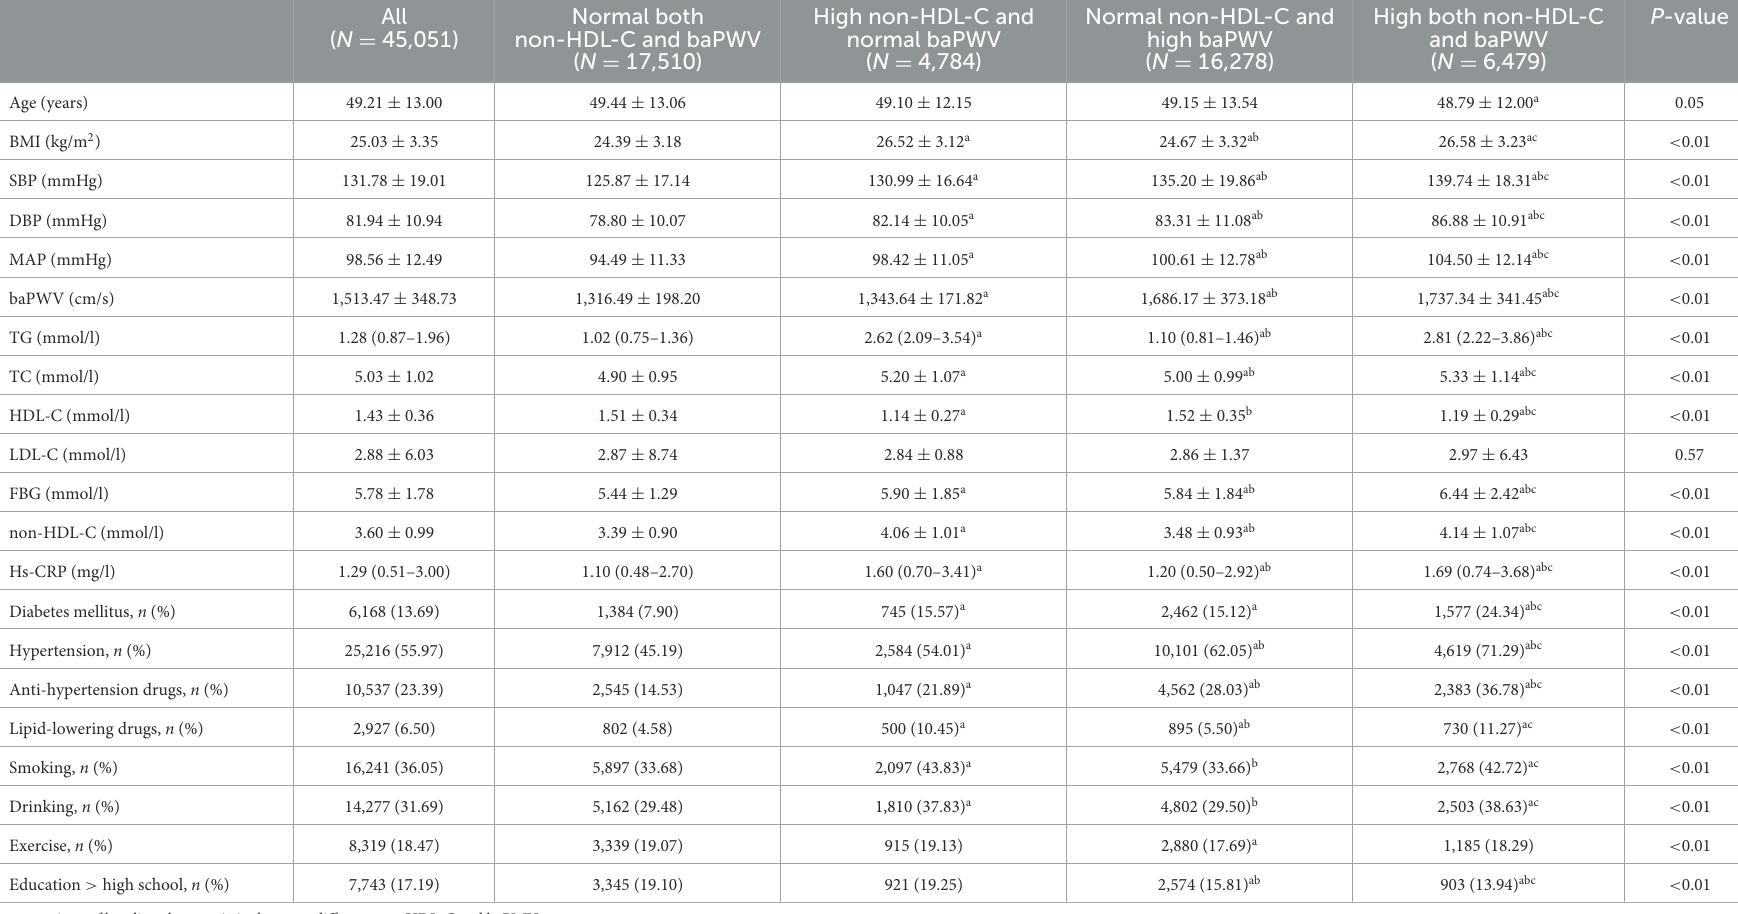
TABLE 1 Baseline characteristics of participants by non-HDL-C and baPWV status.